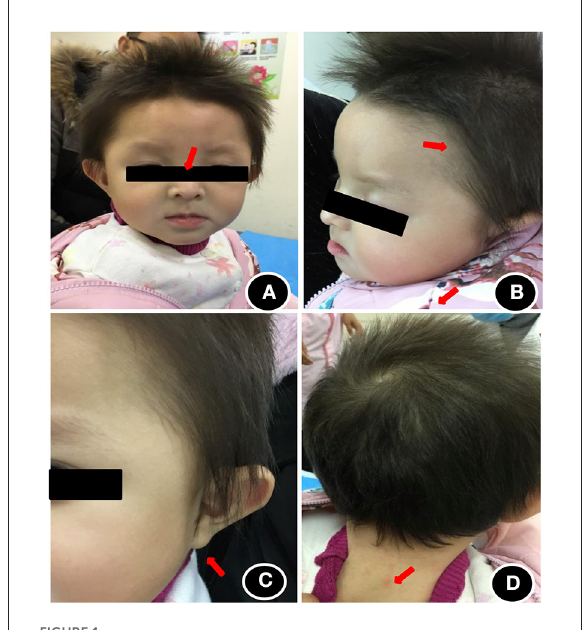
FIGURE1 Head and facial features of the child at the age of 1 year. (A) Wide eye spacing, sparse eyebrows, light color; (B) Loose hair, sparse hair, light color; (C) abnormal auricle appearance; (D) dry and eczema-prone